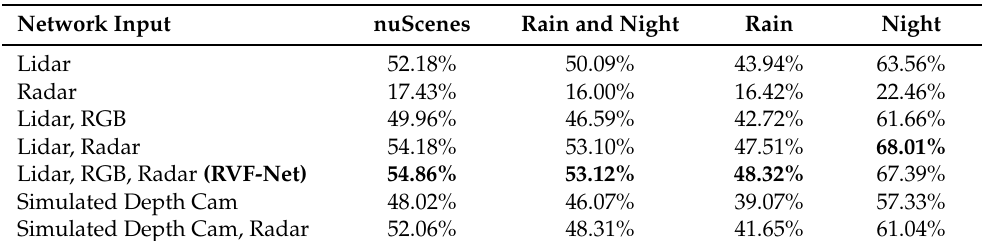
Table 2. AP scores for different environment (data) and network configurations on the respective validation data set.